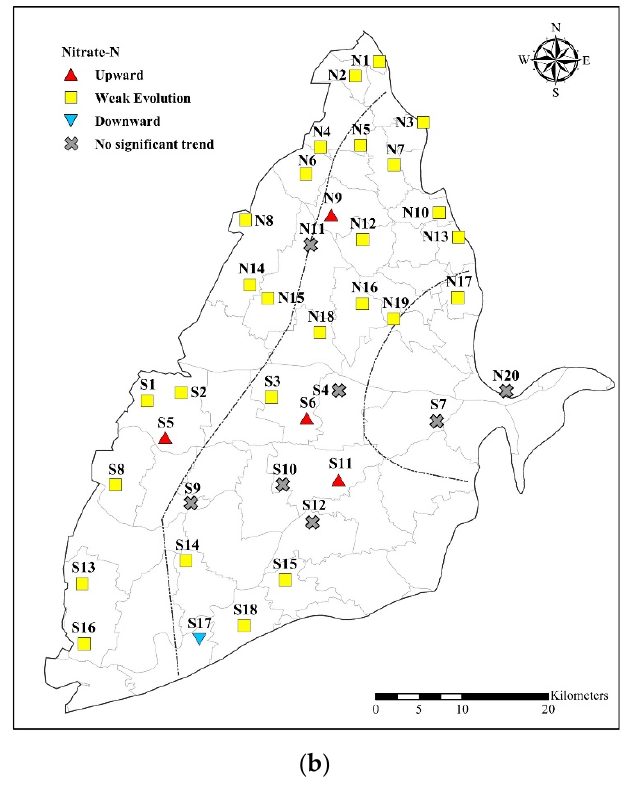
Figure 6. Spatial distribution of the MK test coupled with slope estimation under various classifications, for ( a ) ammonium-N and ( b ) nitrate-N concentrations. Table 4. The MK test coupled with slope estimation under various classifications.